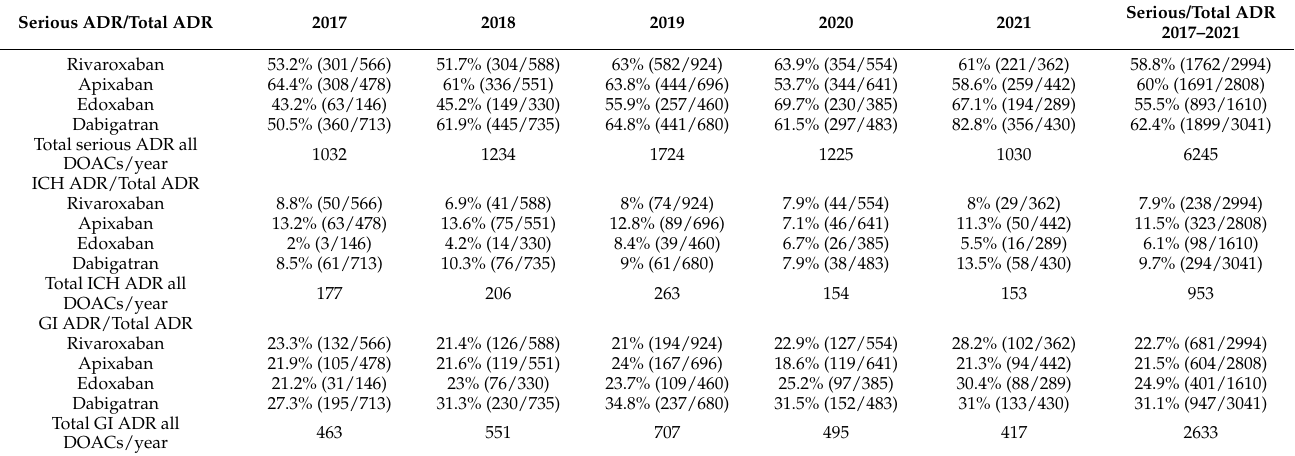
Table 1. Rates of serious ADR, GI ADR, ICH ADR for each molecule from 2017 to 2021.